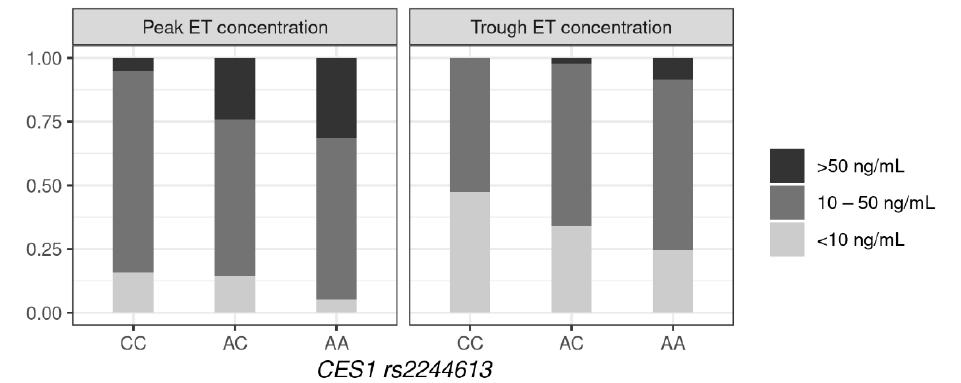
Figure 3. Similarity of enalaprilat concentrations in the therapeutic range, based on the CES1 rs2244613 genotype.